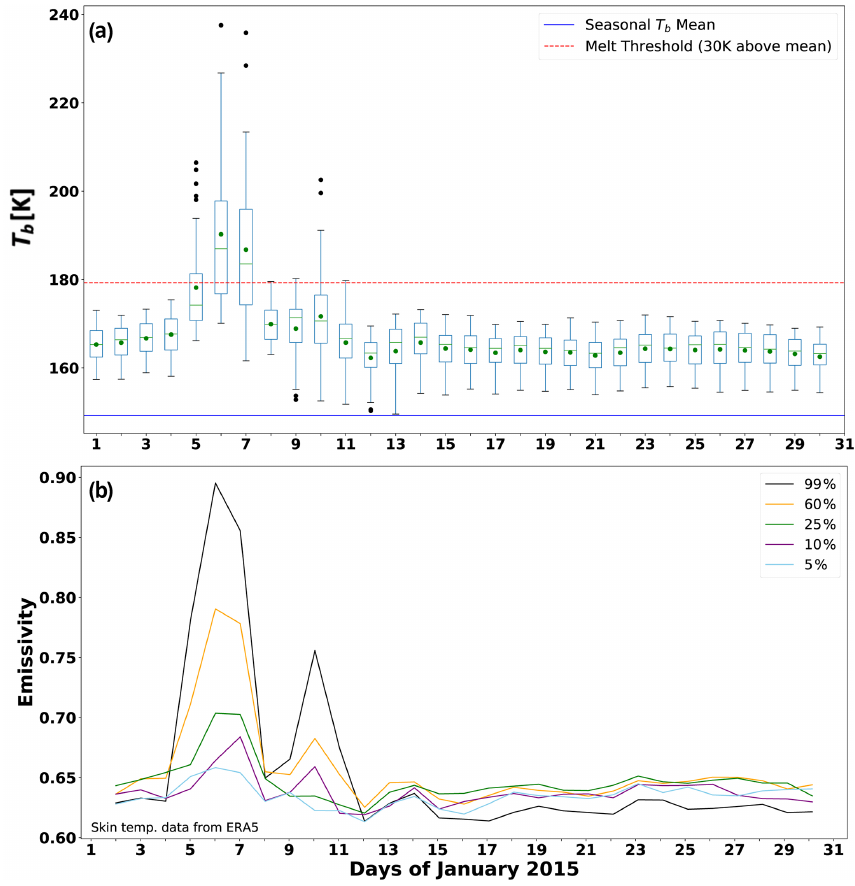
Figure 3. (a) Time series of daily evening overpass SSMIS brightness temperatures T b over the Siple Dome region during January 2015 as daily statistics, with the box denoting the first to third interquartile range ( Q 1 to Q 3 ), the horizontal line in the box denoting the median, the green dot denoting the mean, the whiskers denoting the distance 1.5 ( Q 3 – Q 1 ), and individual black points beyond them denoting outliers beyond the range 1.5 ( Q 3 – Q 1 ). The blue horizontal line is the prior cold season mean, and the red horizontal line is the standard melt detection threshold lying 30K above the prior cold season mean (Tedesco 2009). (b) Five estimates of surface emissivity sampled throughout the region with percentiles referenced to the maximum T b value in the region on 6